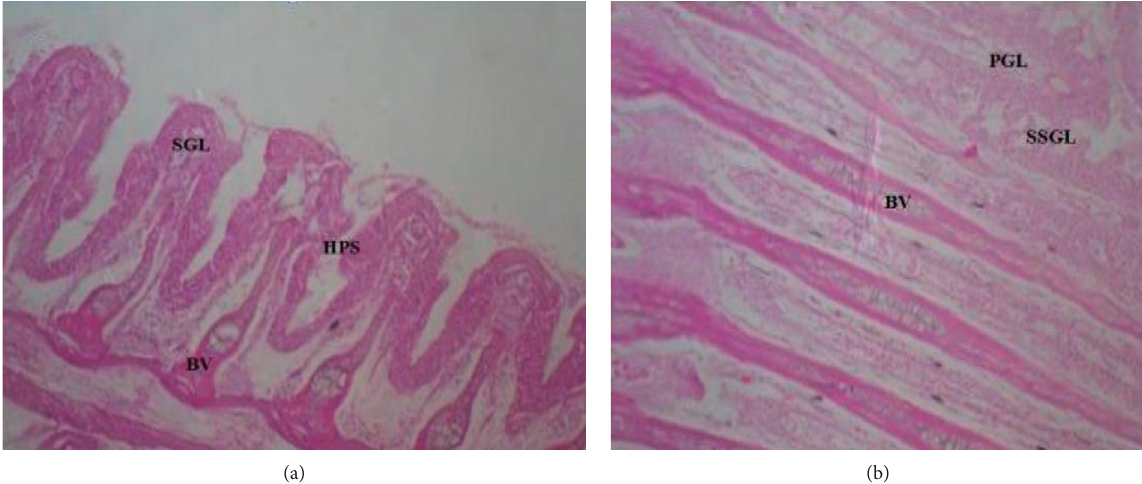
Figure 7: (a) Histological section of gill exposed to nano-SiO/Al 2 O 3 (2:1) showing secondary gill lamella (SGL), blood vessel, and epithelial hyperplasia (HPS) (H&E stains, × 400). (b) Histological section of gill exposed to bulk SiO/Al 2 O 3 (2:1) showing primary gill lamella, shortened secondary gill lamella (SSGL), and blood vessel (BV) (H&E stains, × 400).